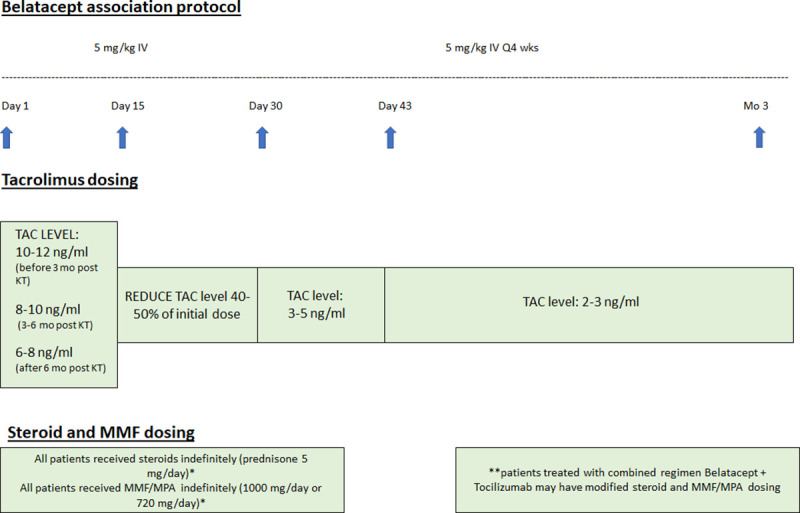
Belatacept association protocol (timeline).